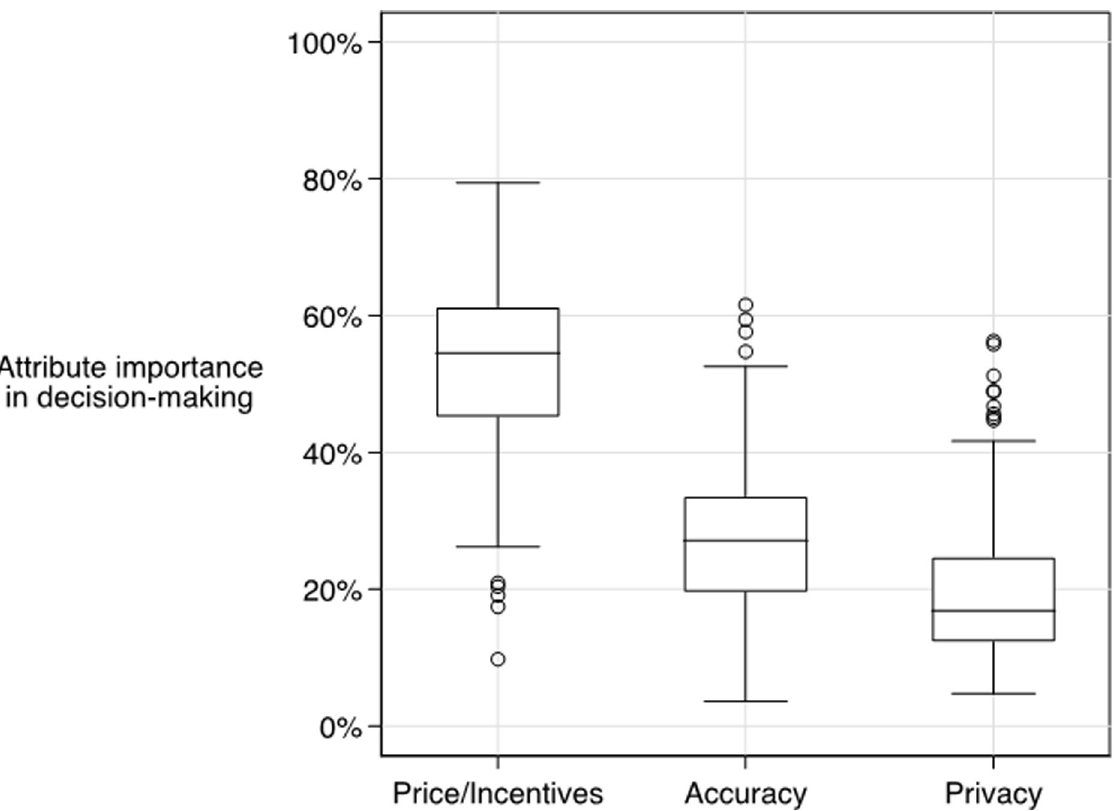
Fig 3. Relative importance of attributes in explaining decision-making about app downloads (n = 394). Notes: Attributes are grouped by strategy as in Table 1. The box plots represent the distributions of relative importance scores, across all individuals who completed the discrete choice